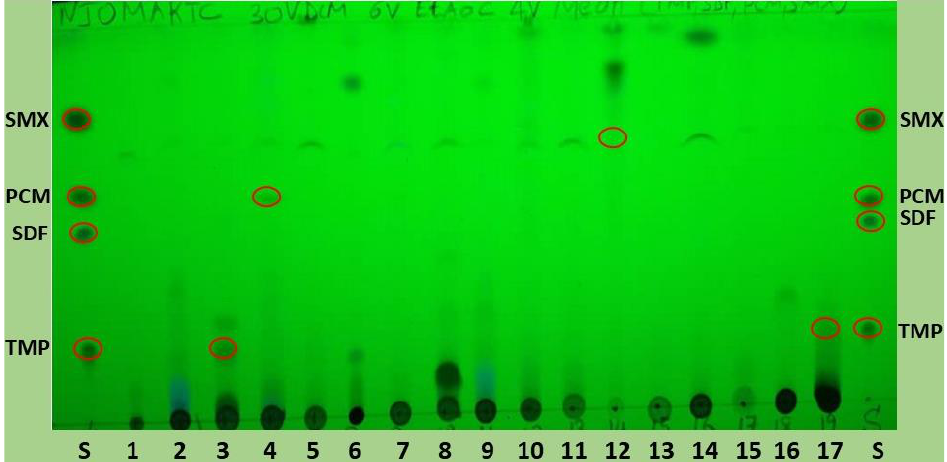
Figure 1. Chromatogram obtained at the separation of samples 1–17 and a mixture of standards, S containing, SMX—sulfamethoxazole, PCM—paracetamol, SDF—sildenafil, and TMP—trimethoprim using dichloromethane:ethyl acetate:methanol (75:15:10, v / v ) and detected in UV light at 254 nm.